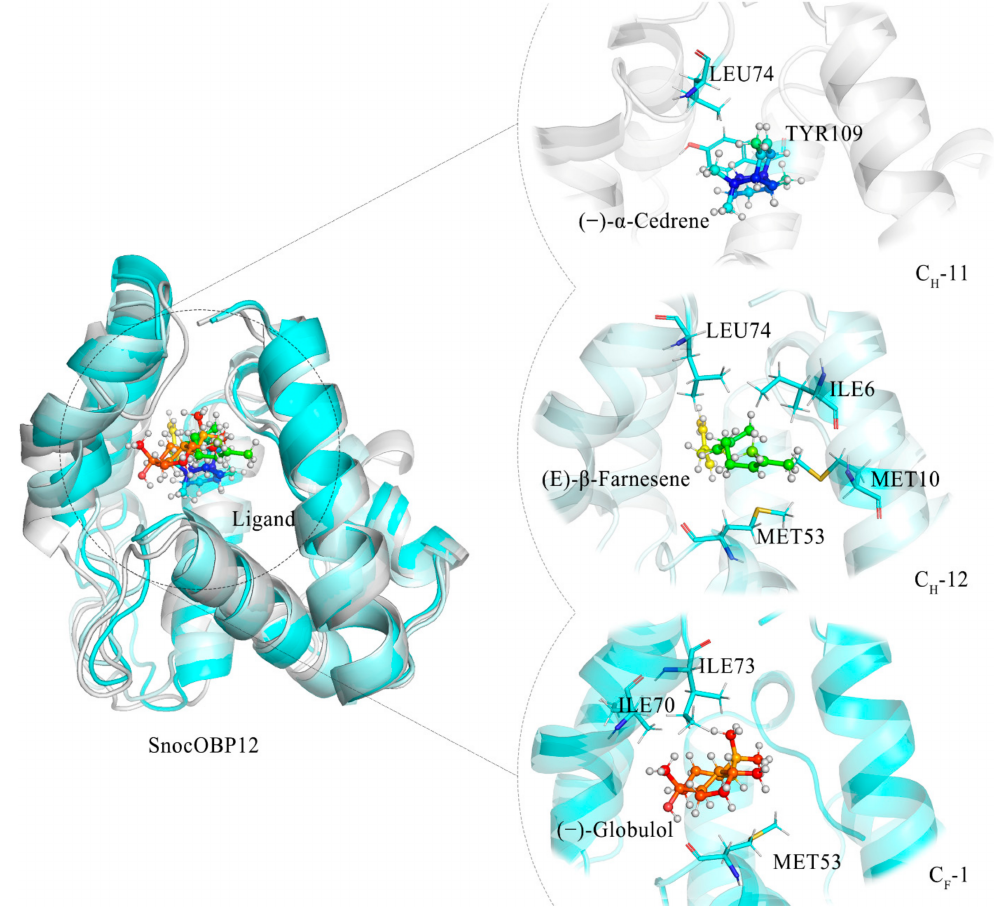
Figure 6. Canonical conformations of C H -11, C H -12 and C F -2 complexes. The residues with binding energy below − 1.0 kcal/mol were individually